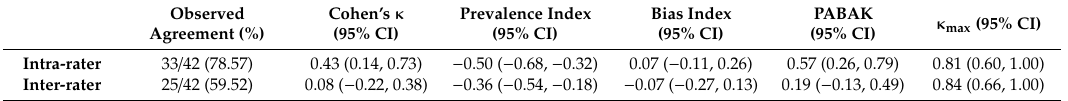
Table 4. Intra- and inter-rater reliability of the Scapula Reposition